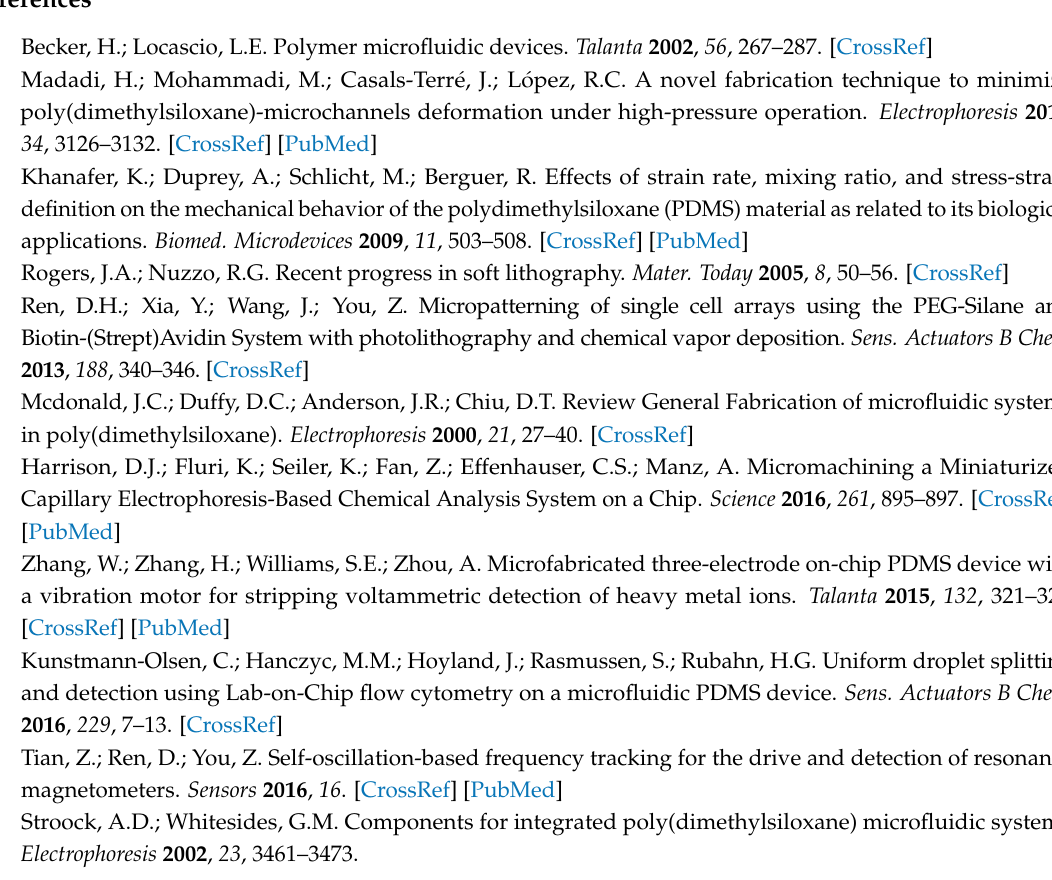
Figure S1: Geometry for simulation and calculating domain, Figure S2: The thickness of the PDMS membrane and its corresponding rotational speed. Figure S3: Measuring points for average thickness of PDMS membrane. Figure S4: Comparison of membrane thickness measured at position A and B. Figure S1: Images of gap structure integrated cell storage unit. Video S1: Video of valve motion. (Available online: